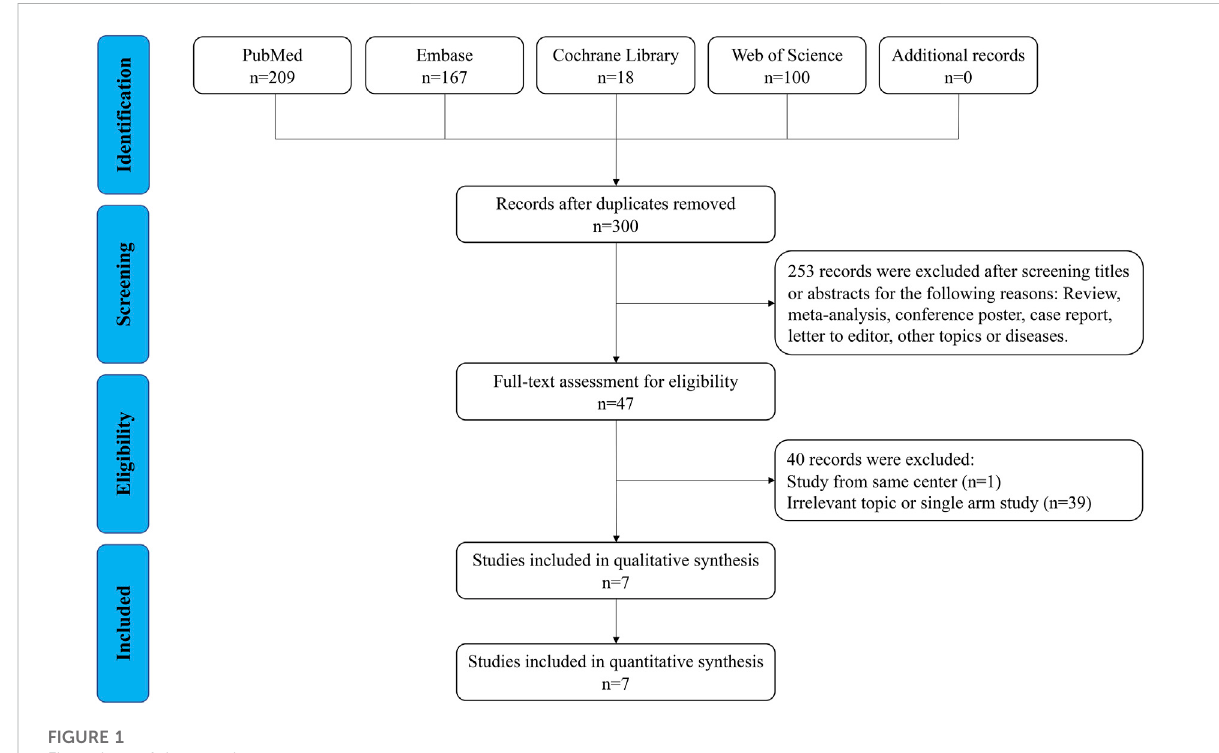
FIGURE 1 Flow chart of the search